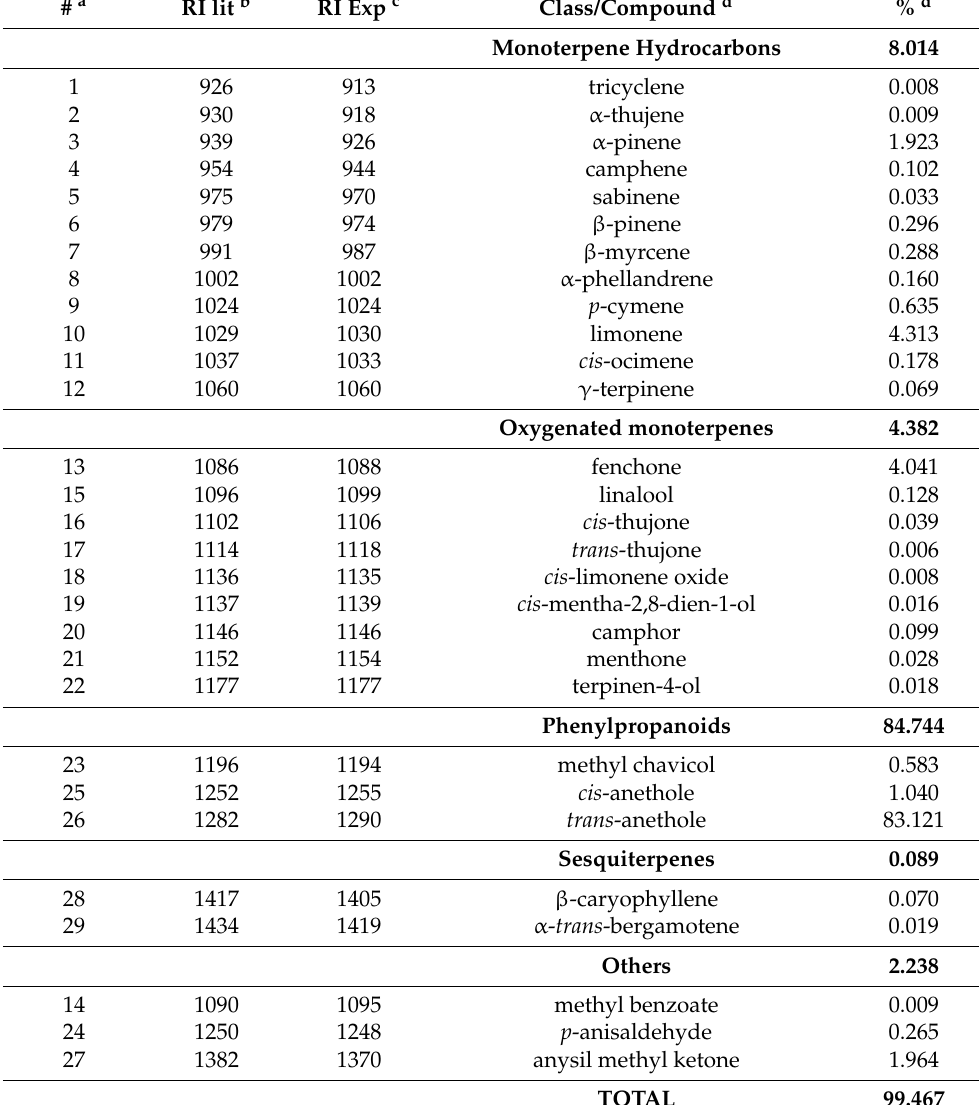
Table 1. Chemical composition of commercial F. vulgare